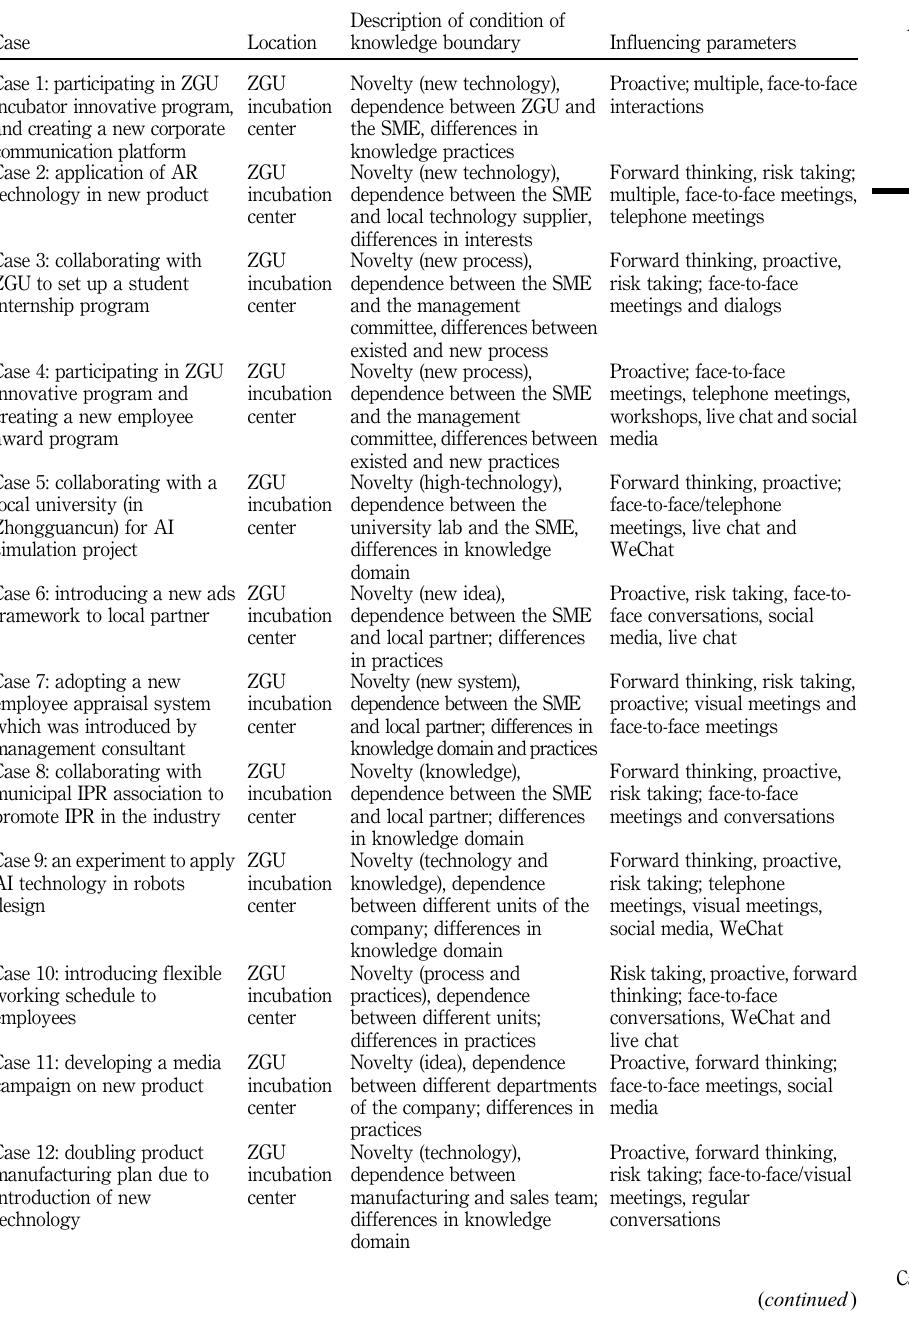
Table II. Cases of knowledge